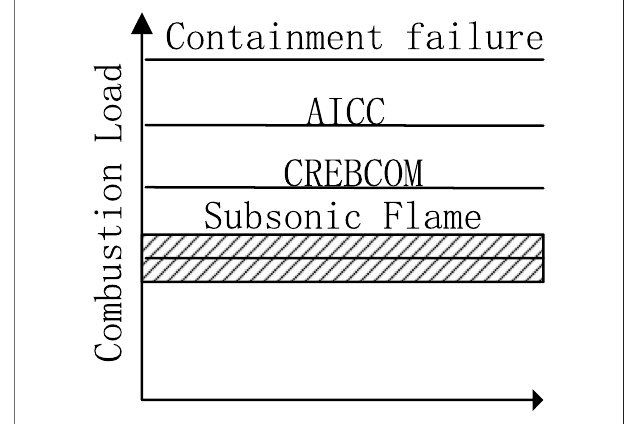
FIGURE 1 | Diagram of safety margins for different combustion analysis